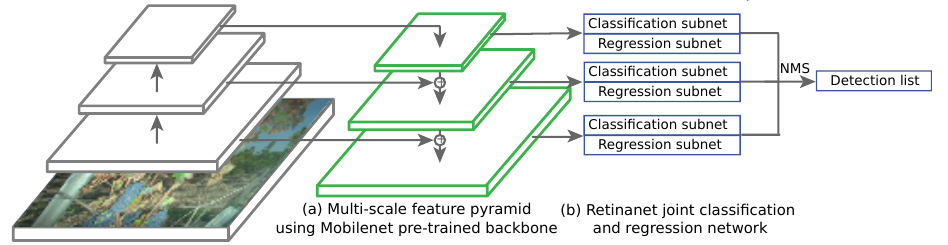
Figure 11. One-step RetinaNet architecture in prediction mode, from full image input to detection list. The whole model is trained using a combination of classification loss and regression loss as the optimized objective function. MobileNet backbone’s convolutional layers were frozen so that only the parameters on the RetinaNet side evolve at a given epoch. Learning and weight updates are performed using standard